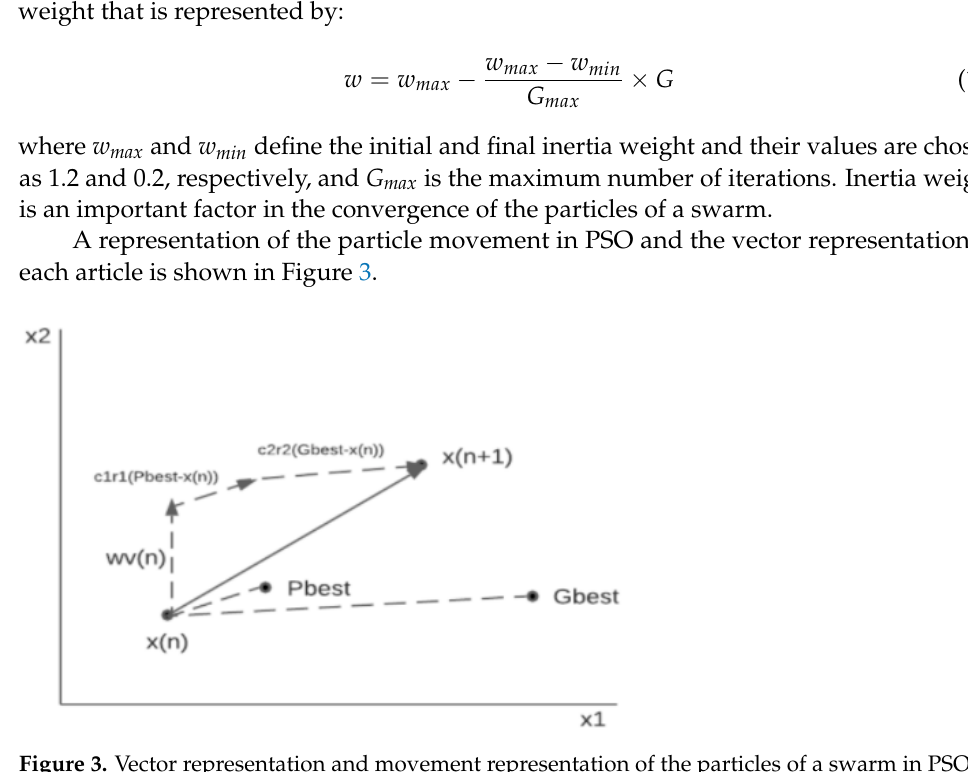
Figure 3. Vector representation and movement representation of the particles of a swarm in